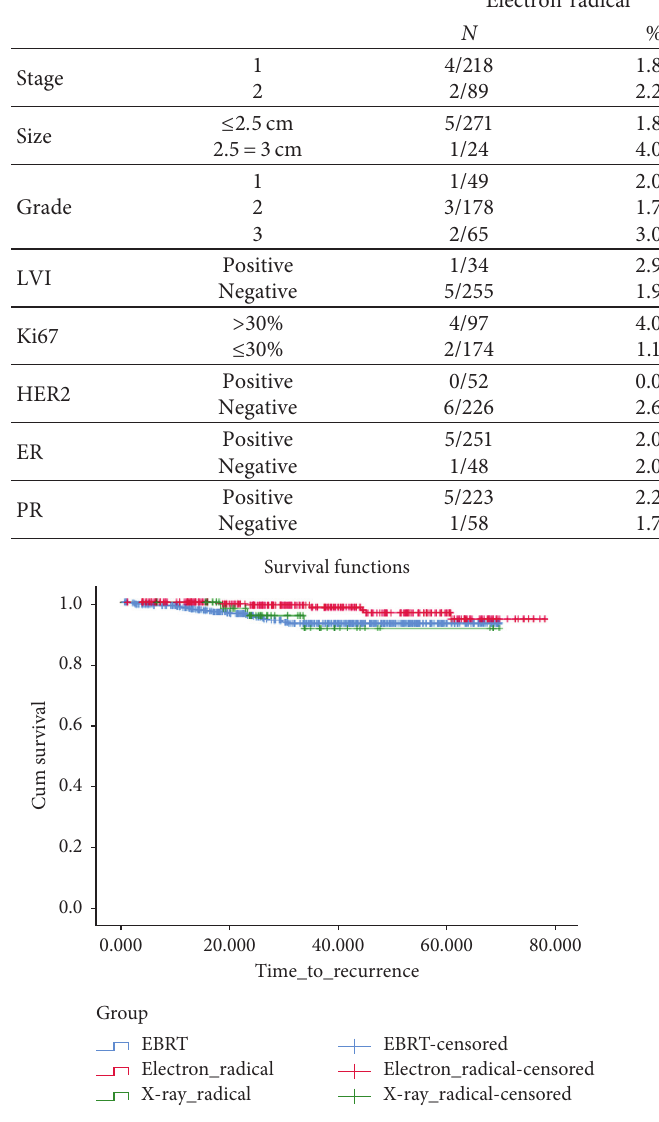
Figure 4: Cumulative incidence of overall survival in the radical groups in comparison with